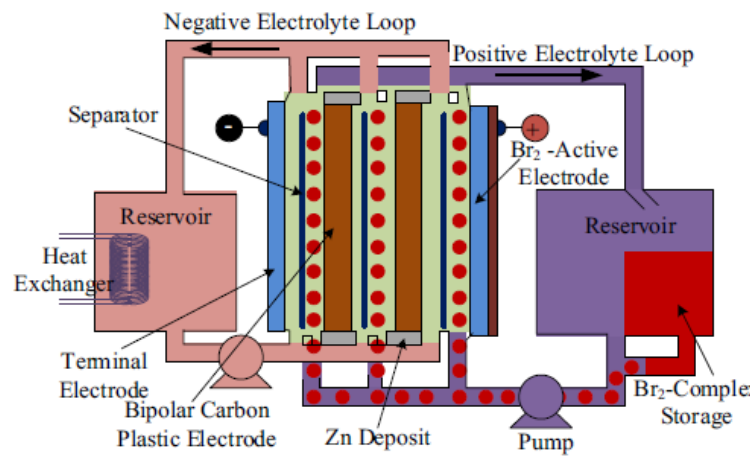
Figure 6. Zinc-bromine battery